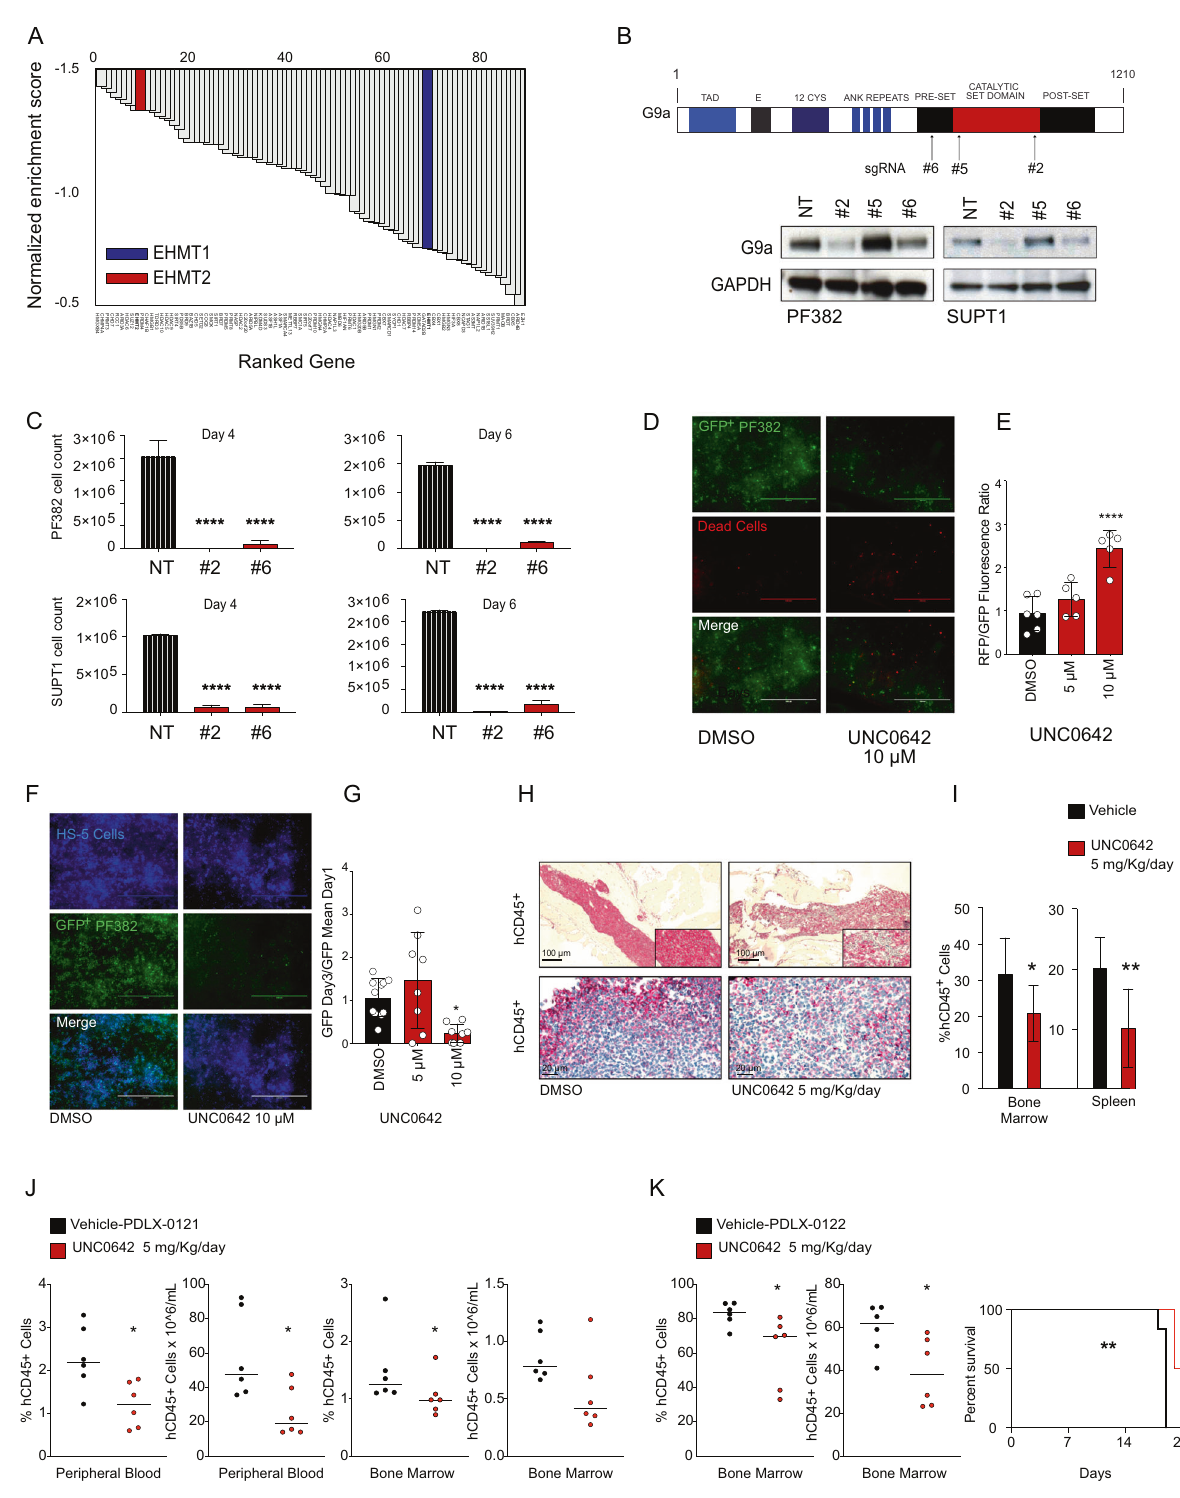
in the bone marrow of xenotransplanted mice compared to the vehicle-administered control group and, consistently, a reduction of leukemic in fi ltration in the spleen (Fig. 2H, I). These studies prompted further in vivo experiments where we demonstrated that UNC0642 reduces leukemic burden both in a slowly growing (Fig. 2J) or fast growing (Fig. 2K) T-ALL patient-derived leukemia xenograft (PDLX)